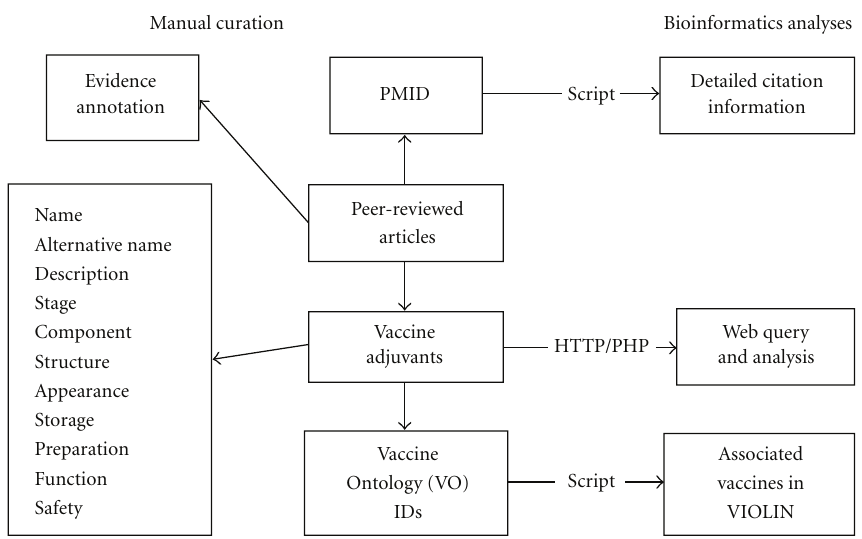
Figure 1: Vaxjo workflow and system design. Manual curation includes peer-reviewed publications from PubMed. A PubMed ID (PMID) is extracted and used by an internal script to retrieve detailed citation information (e.g . , authors, journal, and date). The detailed information of a vaccine adjuvant is curated and cited from published studies. Each vaccine adjuvant is assigned with a Vaccine Ontology (VO) ID, which is further used in an internal computational script to obtain the information of relevant adjuvanted vaccines from the general VIOLIN relational database.